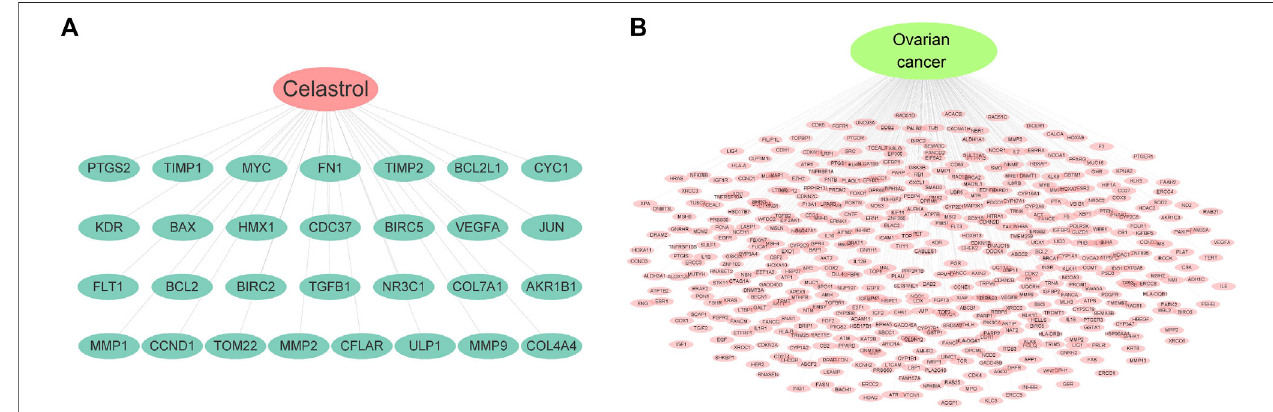
FIGURE 1 | Potential targets of celastrol and ovarian cancer. (A) Targets of celastrol. The pink node represents celastrol, while green nodes show the related targets. (B) Targets of ovarian cancer. The green node represents ovarian cancer, while the pink nodes show the related